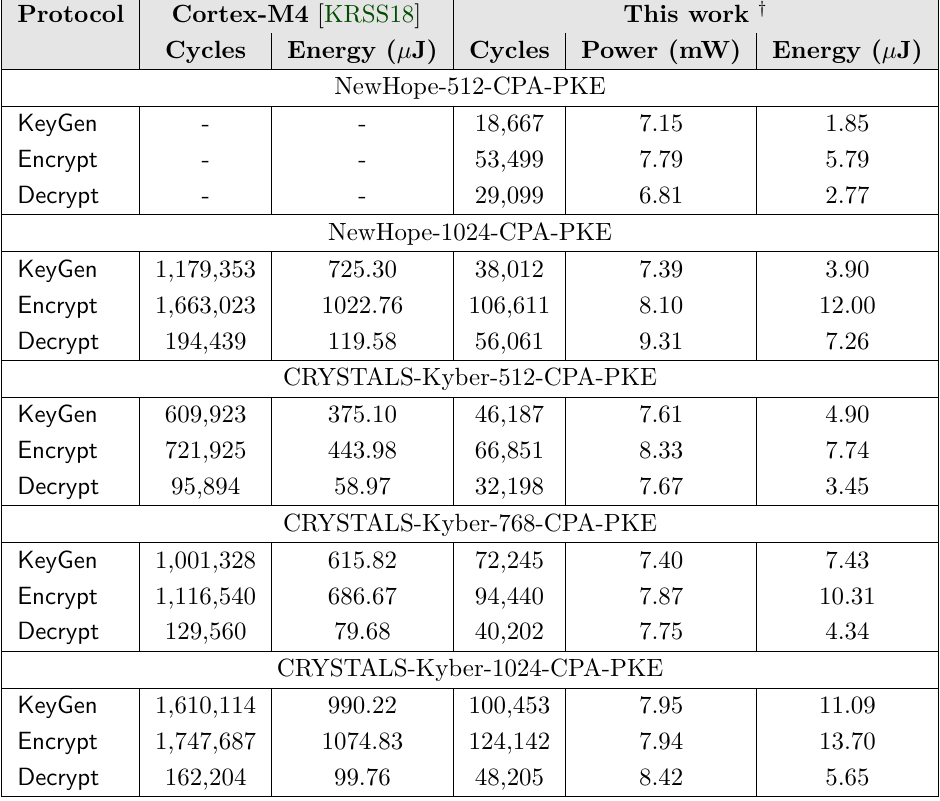
Table 7: Measured energy and performance of public key encryption